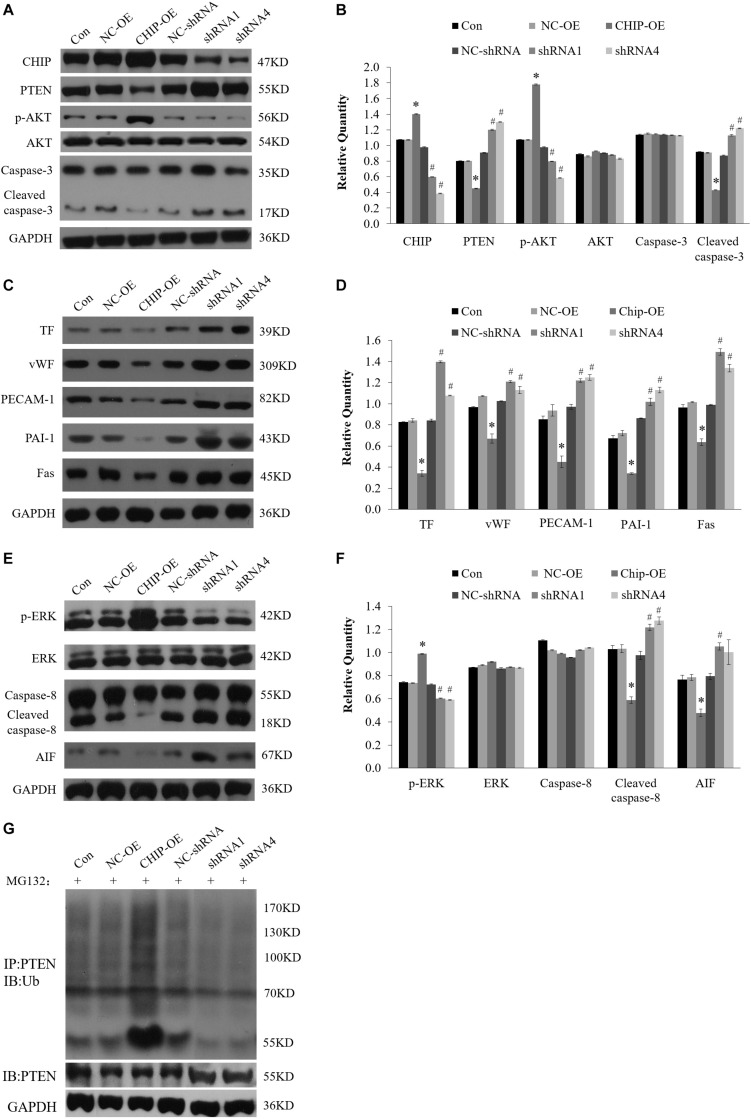
C terminus of Hsc70-interacting protein (CHIP) overexpression attenuated procoagulant and apoptosis molecule expressions after in vitro simulated traumatic brain injury. (A,C,E) Changes of CHIP, PTEN, procoagulant molecules, and apoptosis molecules after in vitro stretch-induced injury treatment. ERK contains ERK1 and ERK2 with the molecular mass of 38–44 kDa; here, the bands of ERK1 and ERK2 were scanned and quantified together as p-ERK/ERK. (B,D,F) Relevant grayscale scanning analysis results of CHIP, PTEN, procoagulant molecules, and apoptosis molecules after in vitro stretch-induced injury treatment. (G) After treatment of MG132 for 12 h, PTEN immunoprecipitation products were tested with immunoblotting. Quantification of proteins was normalized to glyceraldehyde-3-phosphate dehydrogenase. ∗p < 0.05 vs. the NC-OE, #p < 0.05 vs. the NC-shRNA.